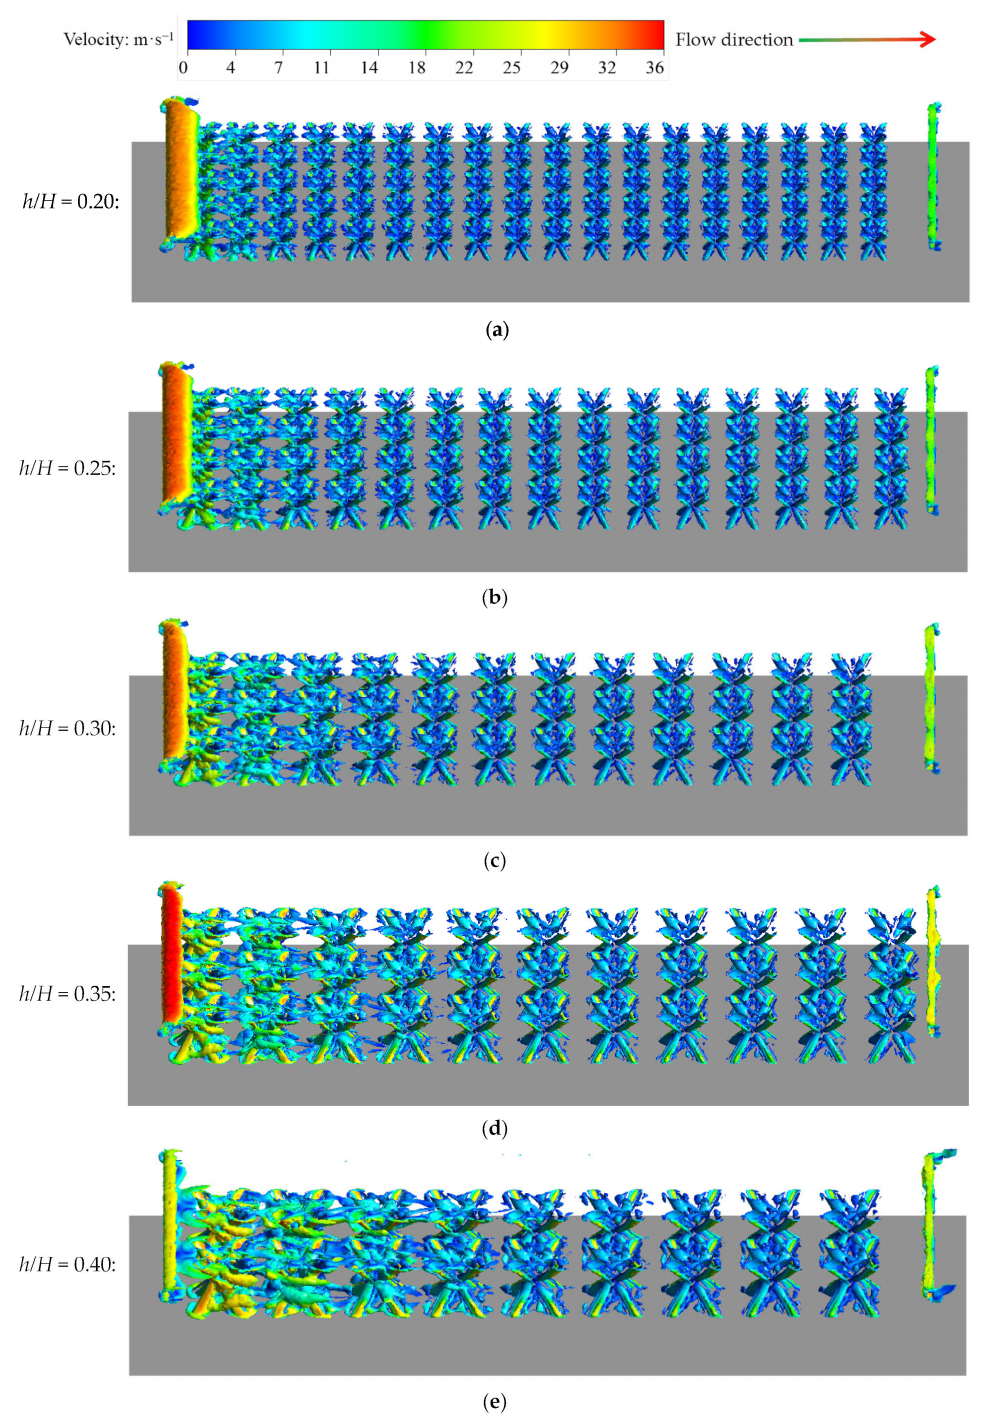
Figure 6. Flow field distributions in X-shaped truss array channels of Scheme 3 at different h/H ( Re = 30,000): ( a ) h/H = 0.20; ( b ) h/H = 0.25; ( c ) h/H = 0.30; ( d ) h/H = 0.35; ( e ) h/H =